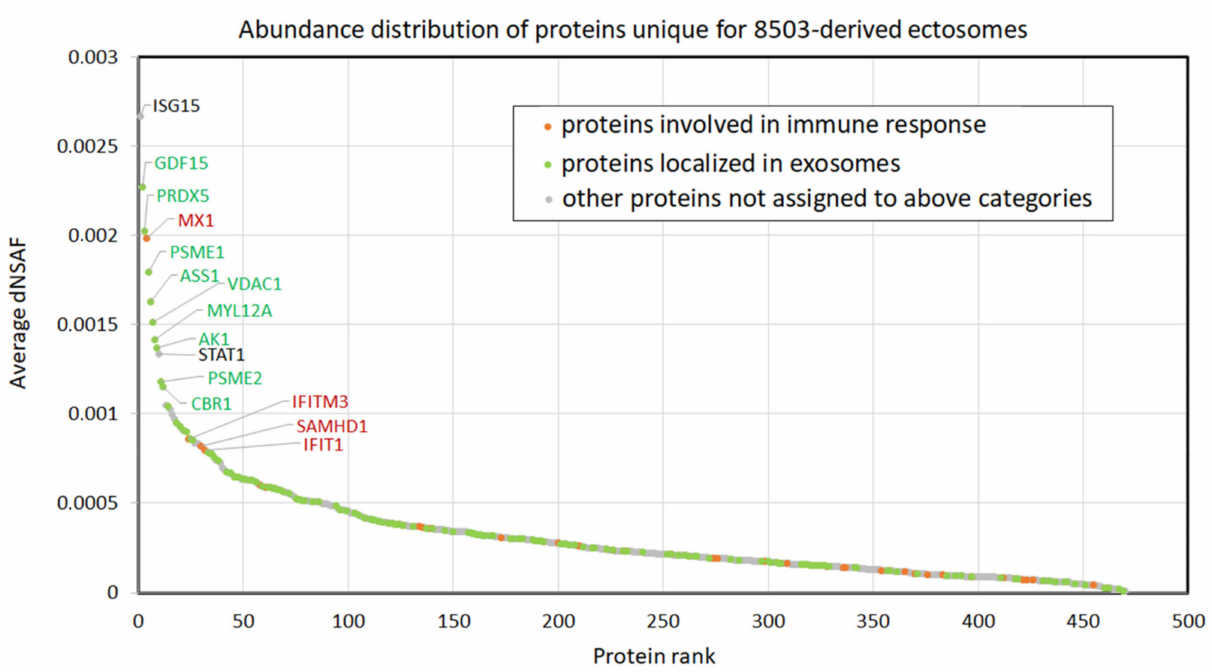
Figure 6. Normalized spectral counting-based abundance of proteins identified uniquely in 8305C-derived ectosomes (not identified in any replicate of Nthy-ori 3-1-derived ectosomes). dNSAF, distributed normalized spectrum abundance factor. Complete results of analysis are provided in Supplementary Data